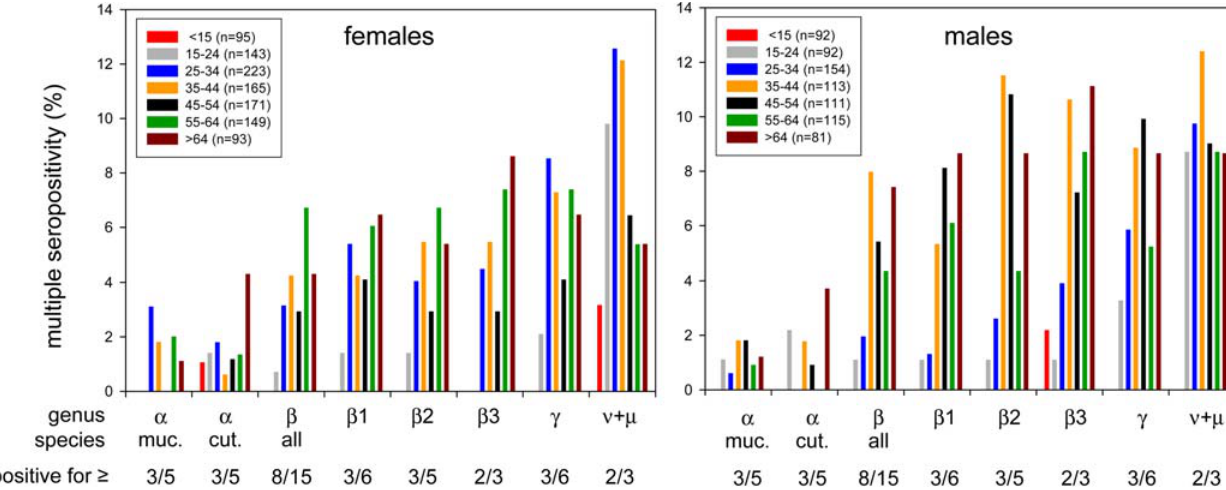
Figure 3. Multiple HPV seropositivity stratified by age and sex. Frequency of multiple seropositivity (seropositivity to at least half of the HPV types analysed within a species or genus) in seven age groups are shown for females and males separately. Colour code, age groups in years and size of the groups are specified in the inserts. Phylogenetic groups (genera and species) and their specific multiple seropositivity definitions (e.g. seropositive for $ 8 out of 15 b PV types) are indicated. muc., mucosal; cut., cutaneous. Multiple seropositivity was lowest for mucosal and cutaneous a PV and in general followed the patterns seen for type-specific seroprevalences (Fig. 2). For m and n PV, it was the earliest to occur in young adults of both genders. For mucosal a PV, it was present mainly in women and peaked at 25–34 years. For cutaneous a PV, multiple seropositivity showed an isolated peak in the oldest age group. For b and c PV, both genders showed two prevalence peaks, in women at around 35 and 60 years and in men some 5 to 10 years